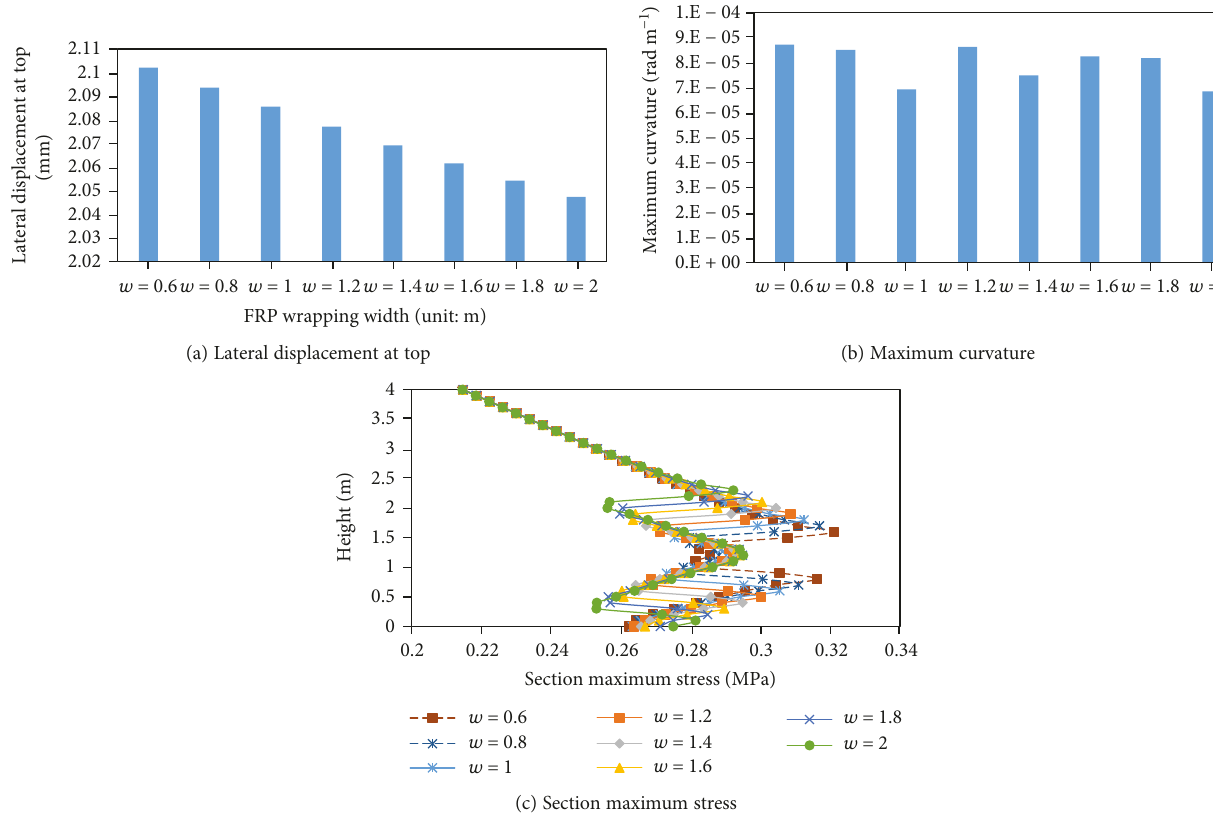
Figure 11: E ff ect of the width of the FRP wraps: (a) lateral displacement at the top of the stem, (b) maximum curvature, and (c) section maximum stress. (w=width of FRP